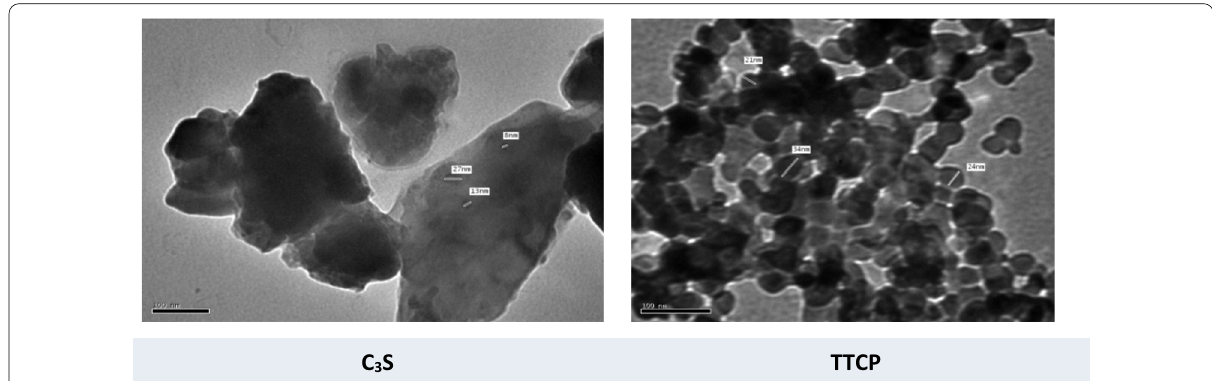
Fig. 2 Transmission electron photomicrographs (TEM) of tricalcium silicate (nano-size C 3 S phase: 8–27 nm) and tetracalcium phosphate (nano-size TTCP: 21–34 nm)